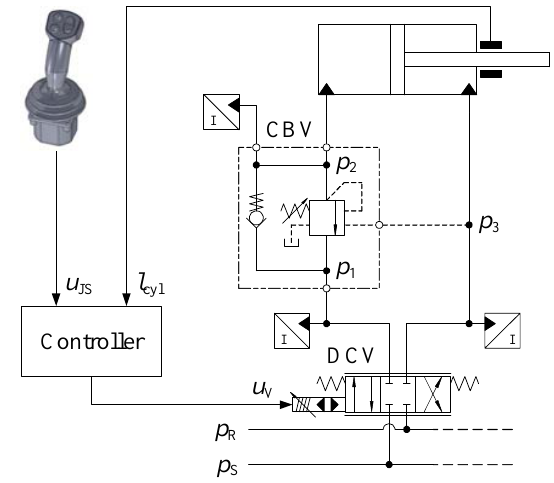
Figure 2: Simplified schematic of motion control sub- system for inner jib.